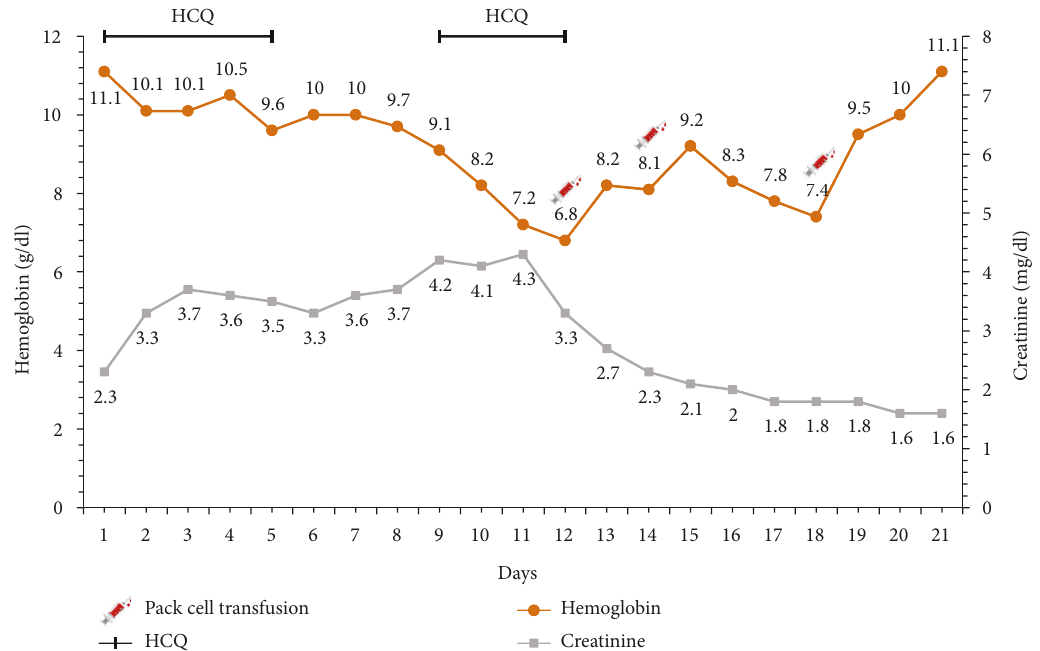
Figure 1: Laboratory course of the patient’s hemoglobin and creatinine during